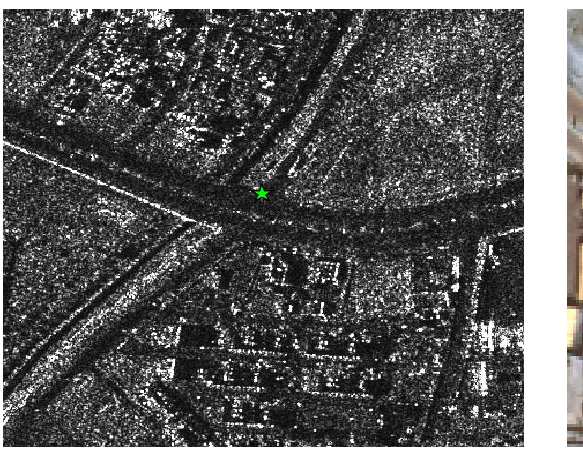
Figure 3. An example of a ground control point (GCP) selected in ( a ) the synthetic aperture radar (SAR) image and ( b ) the optical